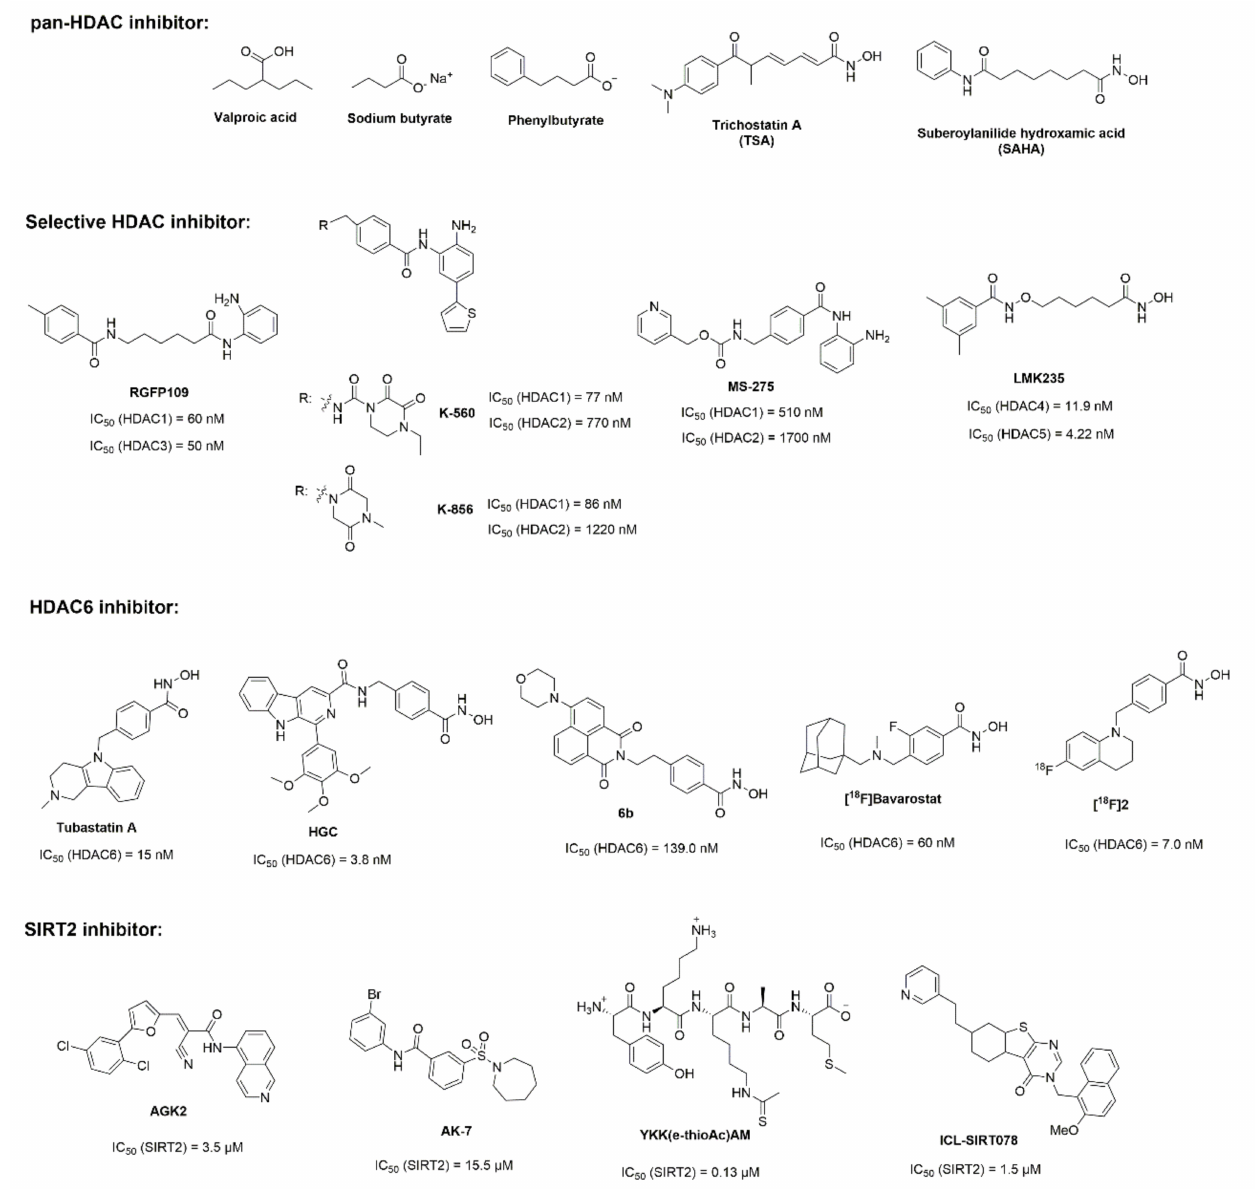
Figure 2. The structures of representative inhibitors of histone deacetylases used in PD